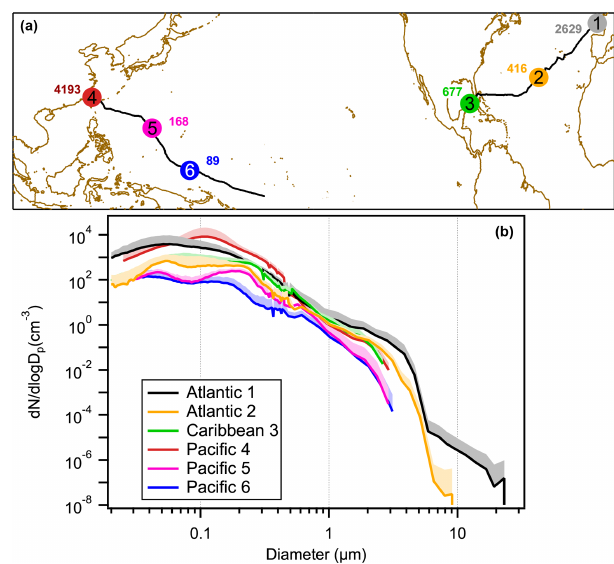
Figure 1. (a) Tara ’s route across the Atlantic Ocean, Caribbean Sea, and Pacific Ocean. Circles indicate the locations of the MSDs used in this study, with total number concentrations (cm − 3 ) written next to each circle. (b) All MSDs; shaded areas represent the upper stan- dard deviation. Each colored curve in panel (b) is associated with a specific location and total concentration marked in the same color in panel (a) . Each MSD is an average of at least 8h of